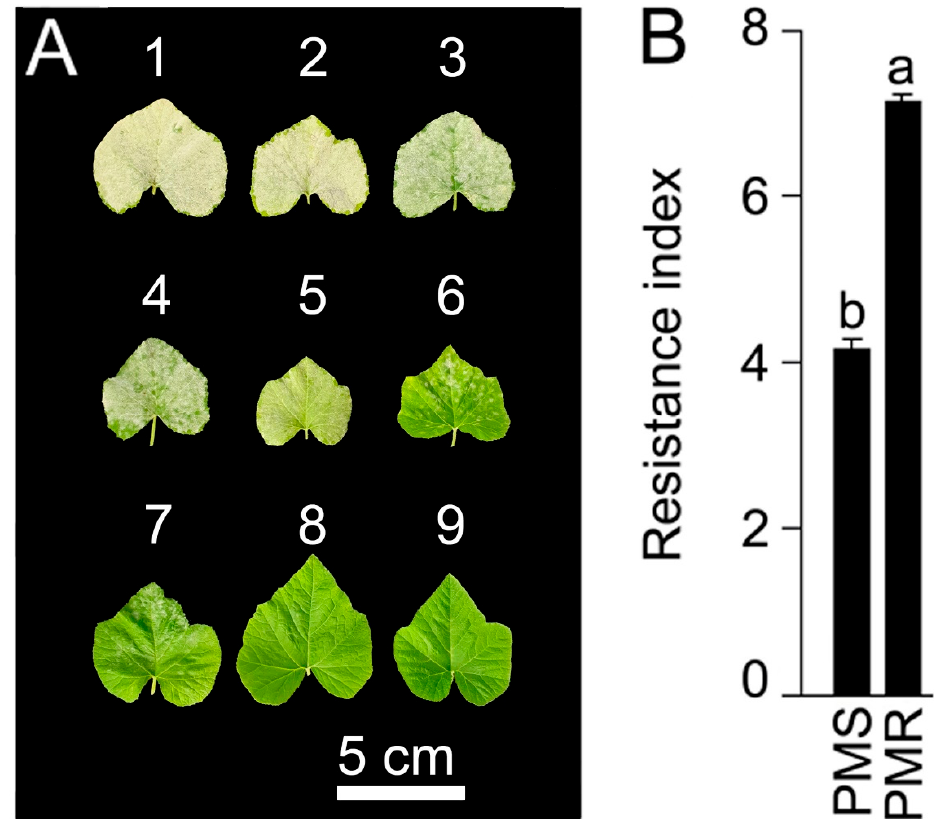
Figure 1. Visual scoring of PM resistance. At an experimental farm, 407 pumpkin genotypes were grown to first true leaf stage (~14 d after germination). Seedlings were infected twice at 5 d intervals, with PM suspensions collected from the heavily infected plants. After PM infection, leaf samples were gently removed, and the resistance index was scored on a scale of 1–9. ( A ) 1–4: susceptible; 5 and 6: moderately resistant; 7–9: resistant. ( B ) The PMS and PMR were compared for their resistance index. Values are means ±SE ( n = 4), and different letters on the histograms indicate that the values differ significantly ( p < 0.05).